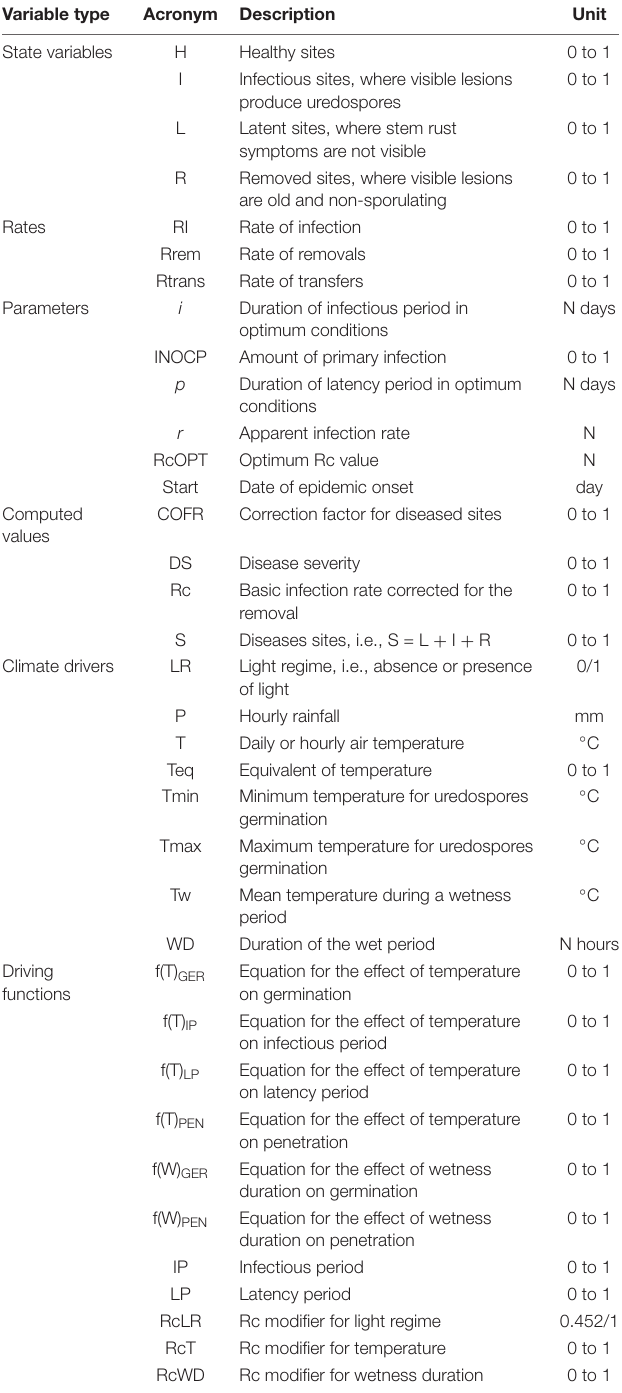
TABLE 1 | List of variables, rates, and parameters used in the model. Variable type Acronym